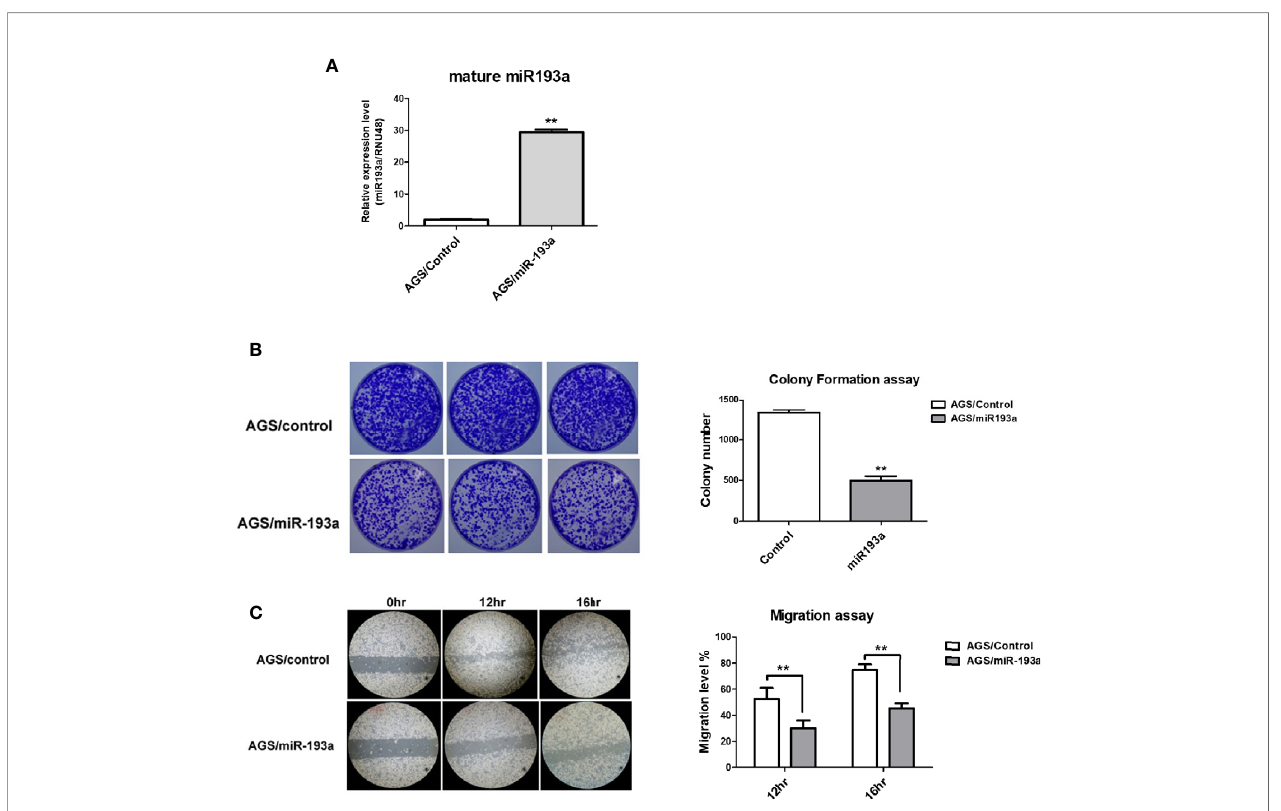
FIGURE 2 | Overexpression of miR-193a inhibits cell proliferation and migration in AGS gastric cancer cells. AGS cells were transfected with control or miR-193a overexpressing plasmid. (A) Relative expression of mature miR-193a in control (AGS/Control) or miR-193a (AGS/miR-193a) overexpressing AGS cells, as determined by quantitative real-time PCR. Proliferation and migration of AGS/Control and AGS/miR193a cells were determined by (B) colony formation assay and (C) wound healing assay. Right panel shows the quantitative analysis of the assay. Each bar represents mean ± SD of duplicate experiments (**p <